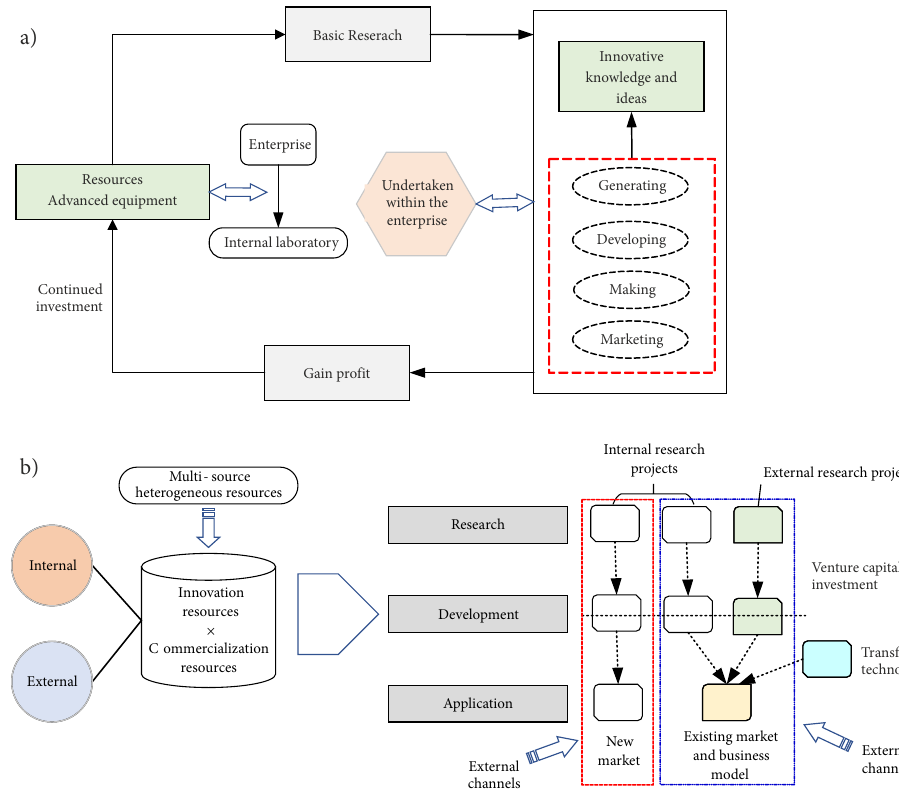
Figure 1. The traditional closed innovation and OI mechanisms: a – the traditional closed innovation mechanism; b – the OI